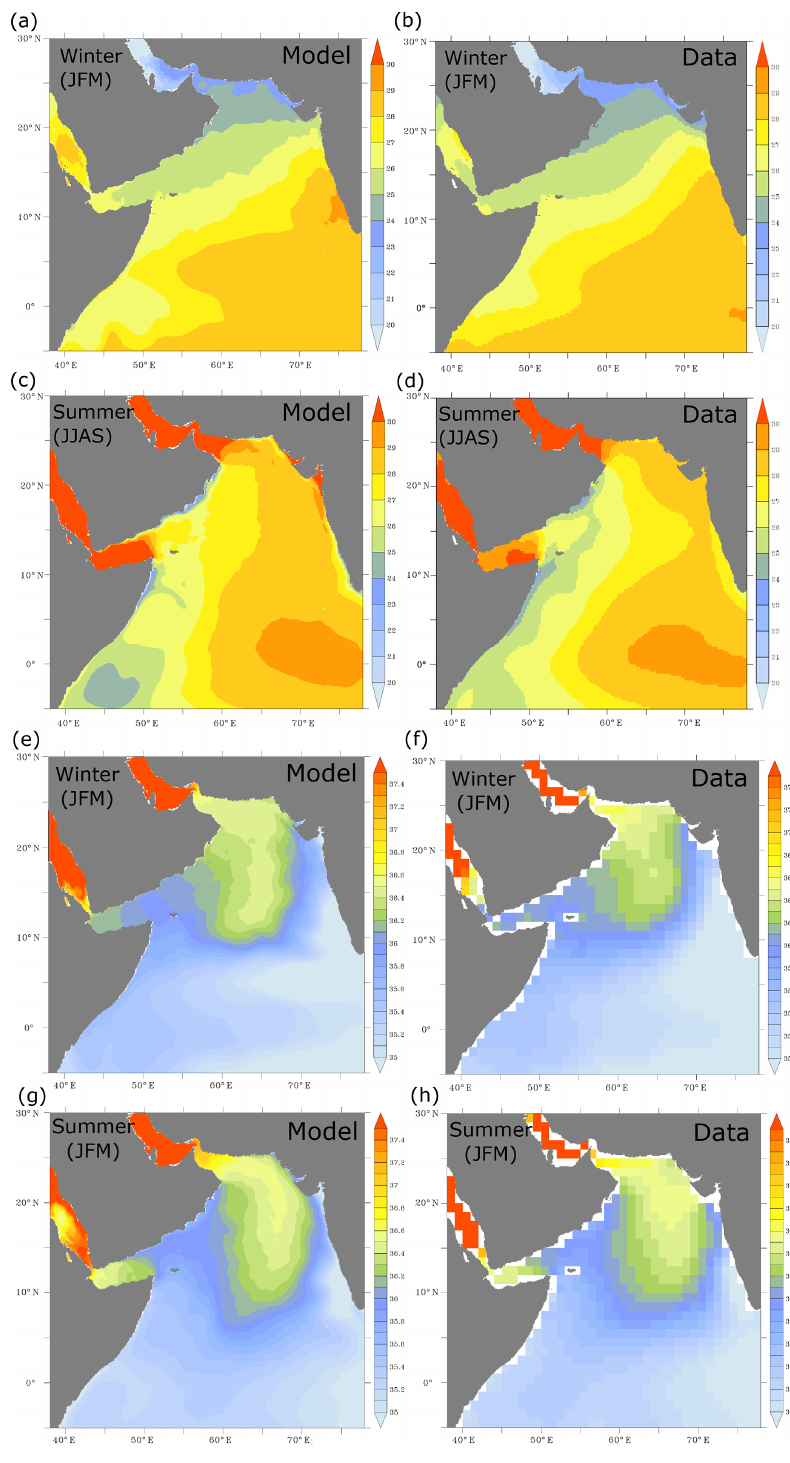
Figure A3. Sea surface temperature and salinity. (a–d) Sea surface temperature (in ◦ C) from ROMS (a, c, e, g) and AVHRR (a, c, e, g) during winter and summer months. (e–h) Sea surface salinity (in practical salinity units – PSUs) as simulated in ROMS (b, d, f, h) and from the World Ocean Atlas (2009) dataset (b, d, f, h) during winter and summer months. The AVHRR observational climatology is computed over the period from 1981 to